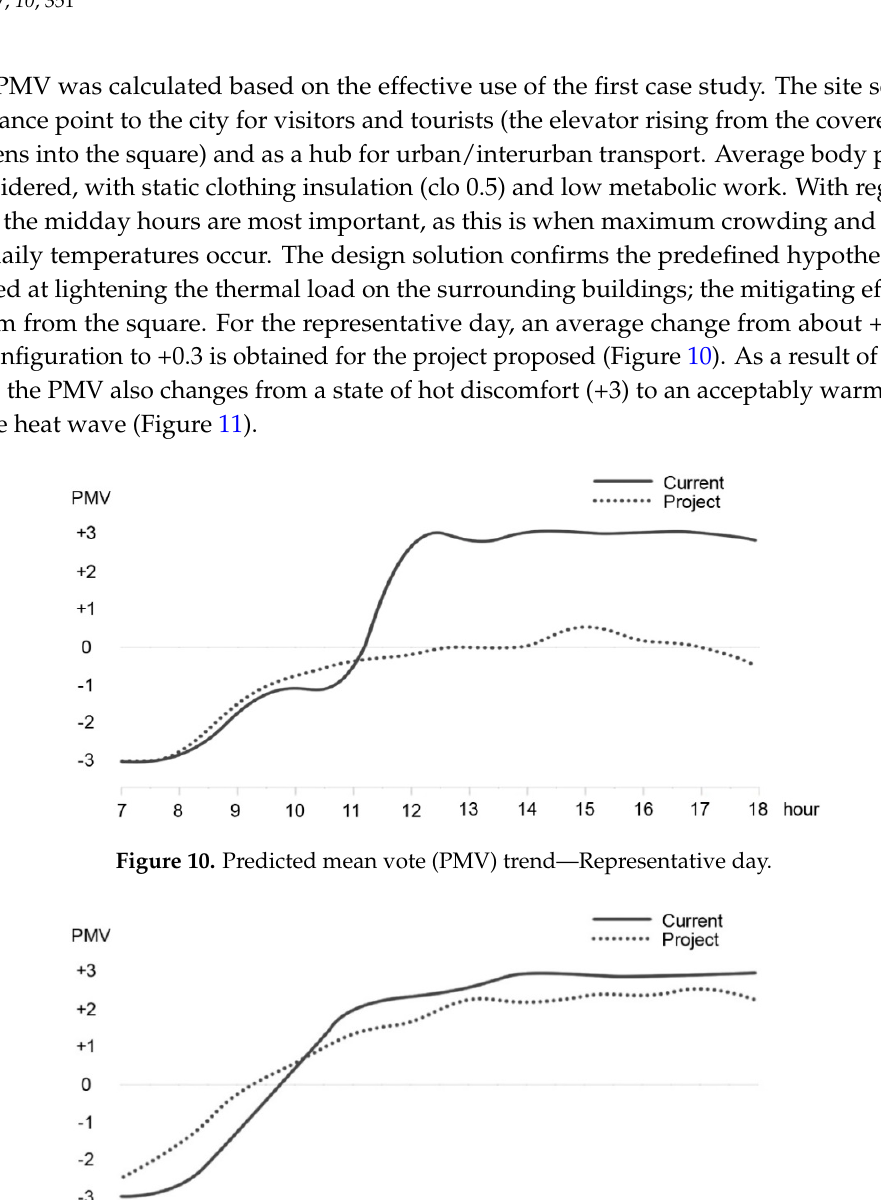
Figure 9. Bus station—Device mitigation during the hottest day.